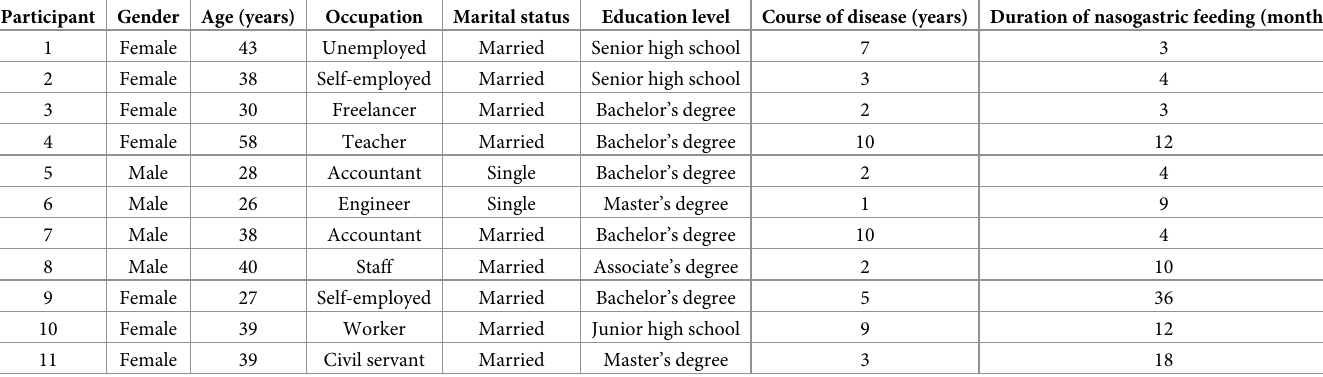
Table 1. Demographic and clinical characteristics of the